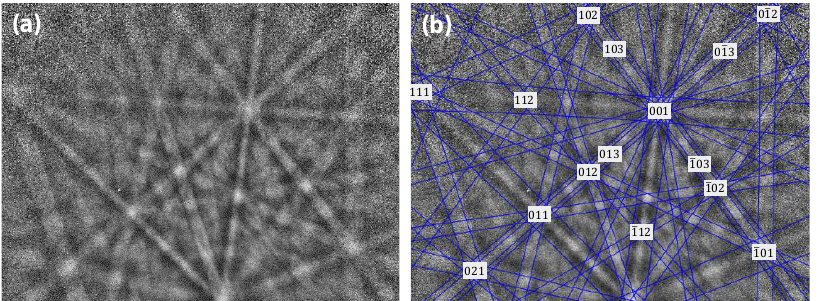
Figure 3. ( a ) EBSD pattern of Nb 3 Sn phase and ( b ) its index calibration in Nb/Sn LSDC annealed at 1200 ◦ C for 2 h. The pattern was acquired with the voltage of 20 kV, and the specimen tilting angle was set to 70 ◦ .